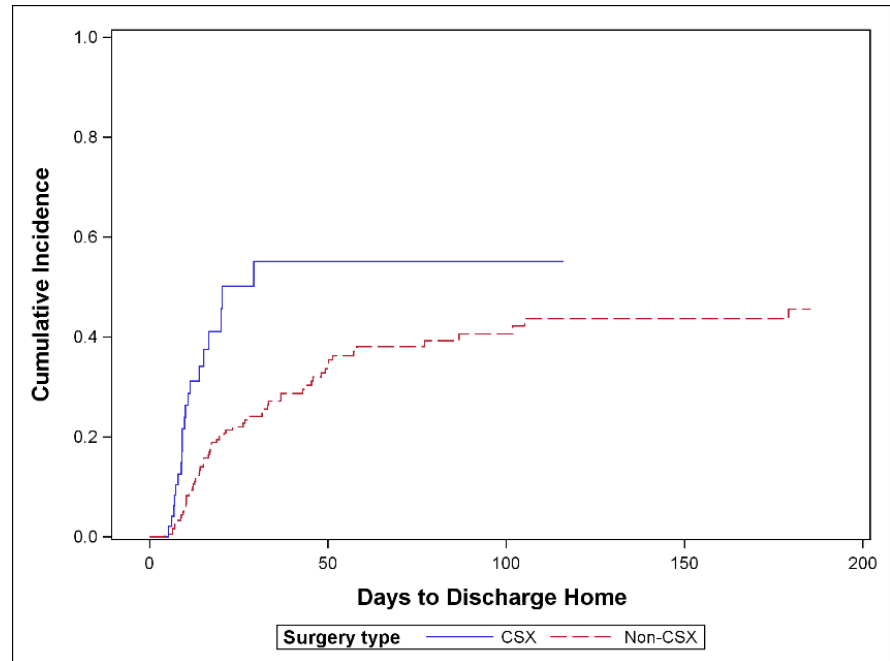
Figure 2. Cumulative incidence of discharge home comparing cardiac surgery versus surgical ICU patients; n = 233 ( p = 0.001); 83 patients discharged home, 74 competing events and 76 censored, CSX = cardiac surgery patients, non-CSX: surgical ICU patients.